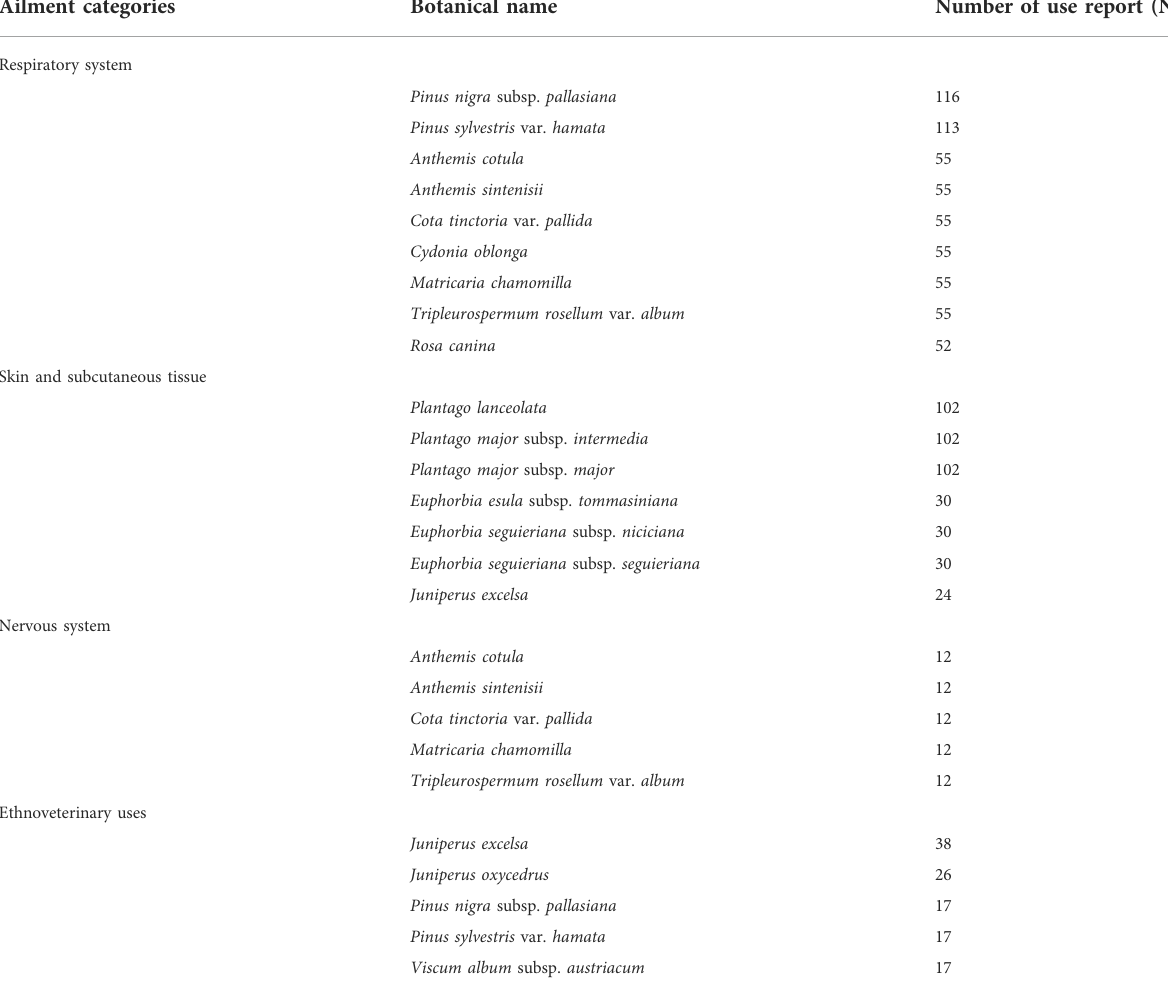
TABLE 6 The most common plant species with high UR in medicinal